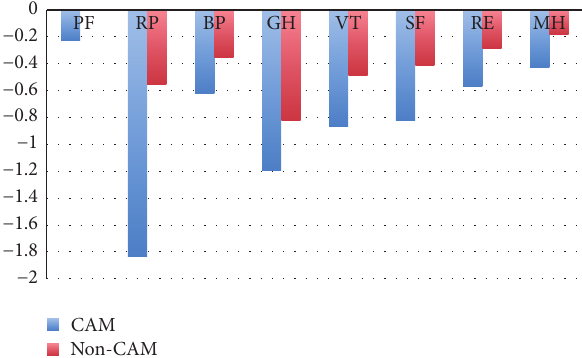
Figure 1: SF-36 scores in CAM users versus nonusers compared to the Norwegian background population. PF: physical function, RP: role physical, BP: bodily pain, GH: general health, VT: